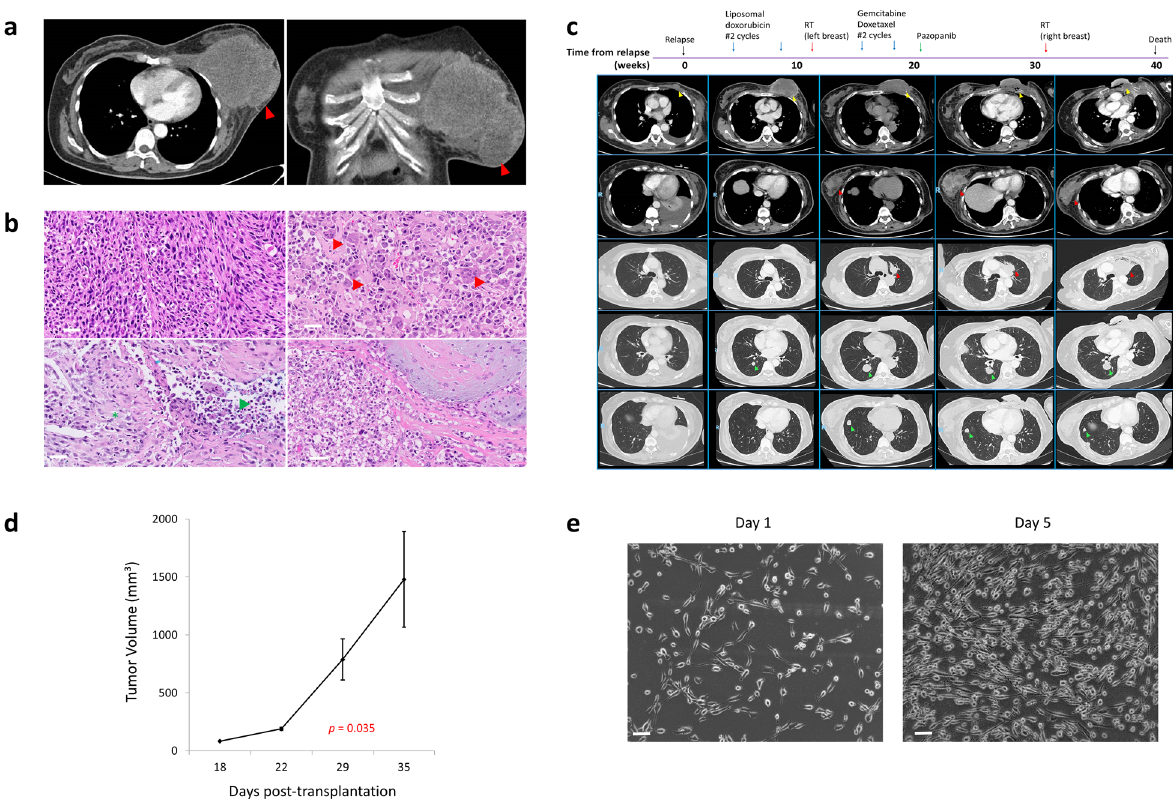
Fig. 1 Establishment of patient-derived xenograft and cell line MPT-S1. a Images of breast tumor on CT imaging (red arrow). b Representative H&E images (20X magni fi cation) of malignant PT with osteoclast-like multi-nucleated giant cells (red arrowhead), epithelioid areas (green asterisk), necrosis (green arrowhead), and myxoid components (bottom right) (scale bar: 50 µm). c Clinical course of the patient from time of relapse till death. d Growth characteristics of the xenograft in NSG mice. e Morphology and growth characteristics of MPT-S1 cell line (scale bar: 20